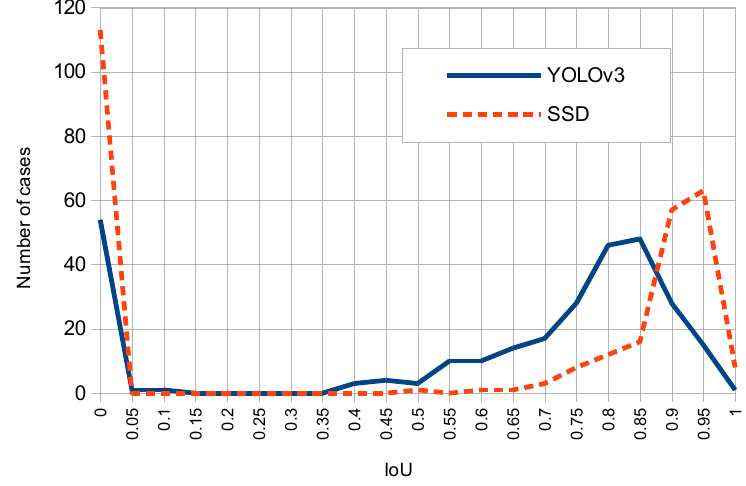
Figure 12. Histograms of respective IoU value distributions for SSD and YOLOv3.